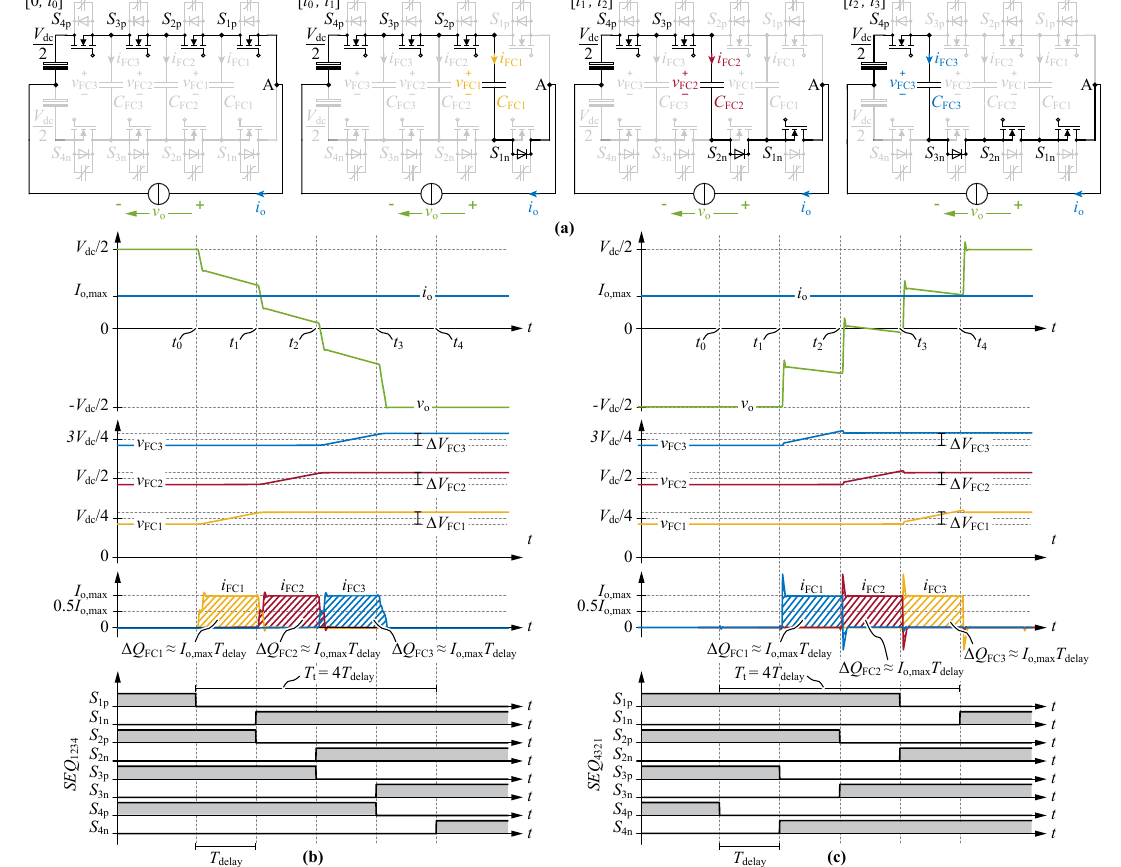
Figure 2. Simulation results for Q2L operation of the 5L-FCC: ( a ) Switching states of a FCC HB with constant positive output current ( I o,max ) during a Q2L switching transition with negative slope of v o , resulting in ZVS. ( b ) Corresponding time intervals and simulated waveforms of output current ( i o ) and output voltage ( v o ), FC voltages ( v FC{1,2,3} ) and currents ( i FC{1,2,3} ), and MOSFET gating signals. ( c ) Time intervals and simulated waveforms for the HS case with positive slope of v o and constant output